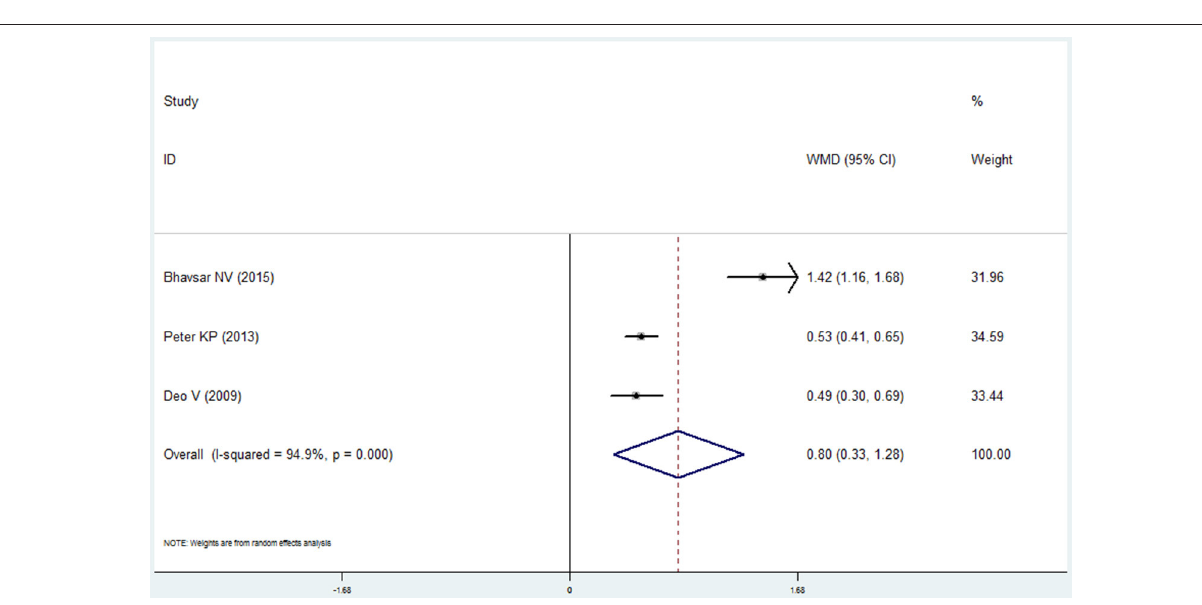
patients. Glucocorticoid, salbutamol, and tiotropium